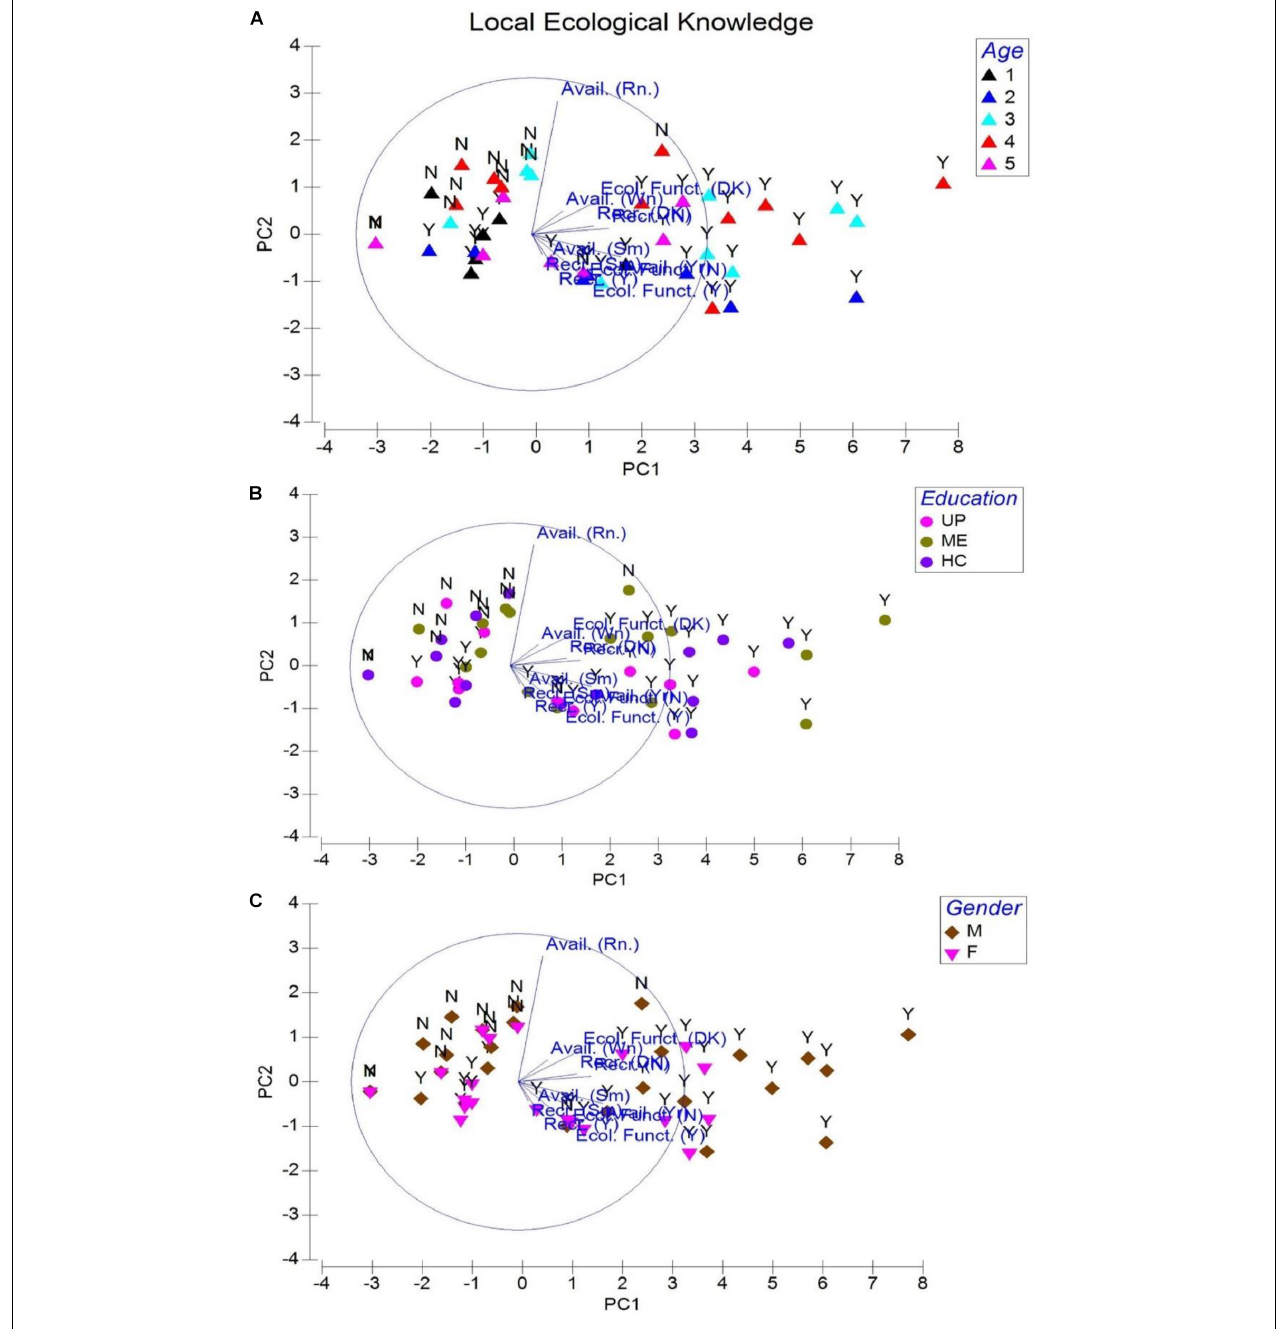
FIGURE 3 | Principal component analysis for local ecological knowledge on Tachypleus gigas. Abbreviations are avail. = availability, Ecol. funct. = ecological function, Recr. = recovery, DK = don’t know, Y = yes and N = no, Rn. = rainy season, Wn. = winter season, and Sm. = summer season are components of the questionnaire that are assigned with values like 1 = yes and 0 = no to develop this analysis. Legends represented by age are 1 = 18–24 (Group 1), 2 = 25–34 (Group 2), 3 = 35–44 (Group 3), 4 = 45–54 (Group 4), and 5 = 55–64 (Group 5). Education is denoted with UP = upper primary, ME = middle elementary, and HC = high school. Gender is represented by M = male and F = female